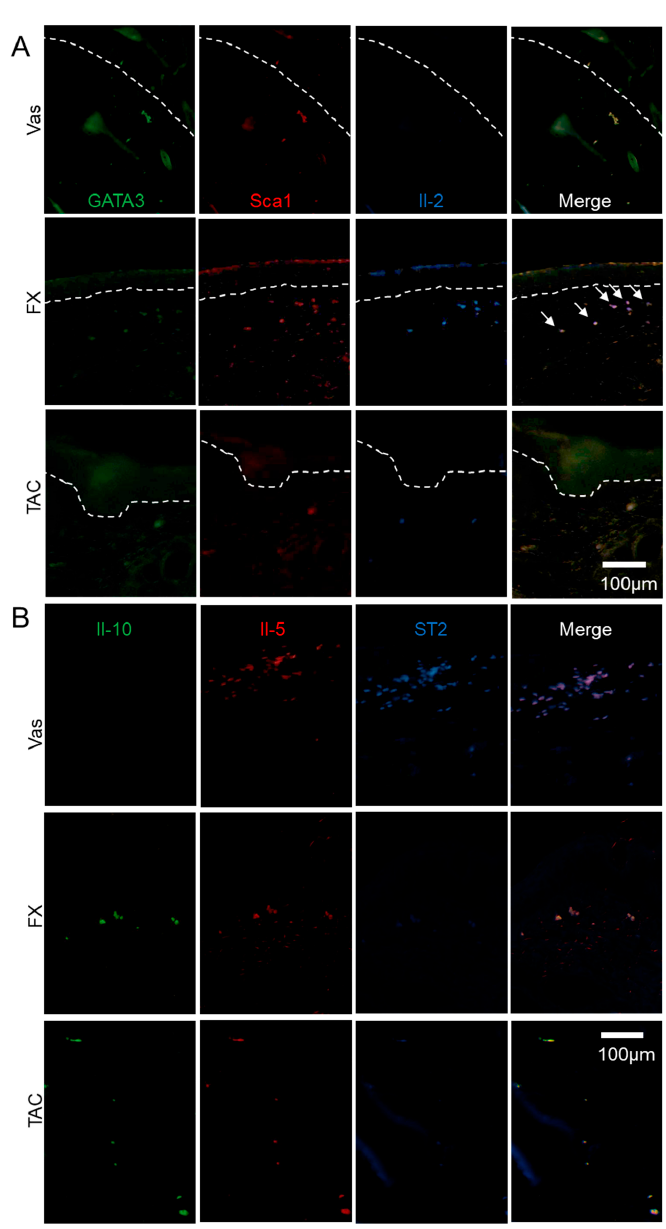
Figure 5. The localization of ILC2 and ILCreg modulated by FX or TAC. FX stimulated Il-2 + GATA3 + Sca1 + ILCreg. Il-2 + GATA3 + Sca1 + ILCreg dominantly expressed in FX-treated Nc/Nga mice ( A ) and Il-5 + ST2 + ILC2 in the Vas treated group ( B ). Sections were reacted with respective fluorescence-labelled antibodies. The area between the dotted lines indicates the epidermal layer. Arrows indicates typical GATA3 low Il-2 high cells (A). Panel (B) is focused on the dermis.